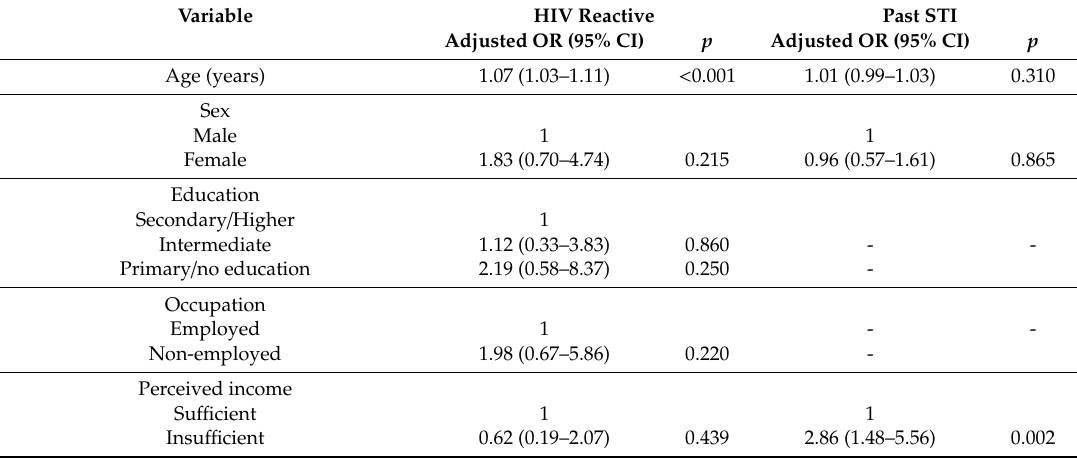
Table 2. Factors associated with HIV reactive test and past